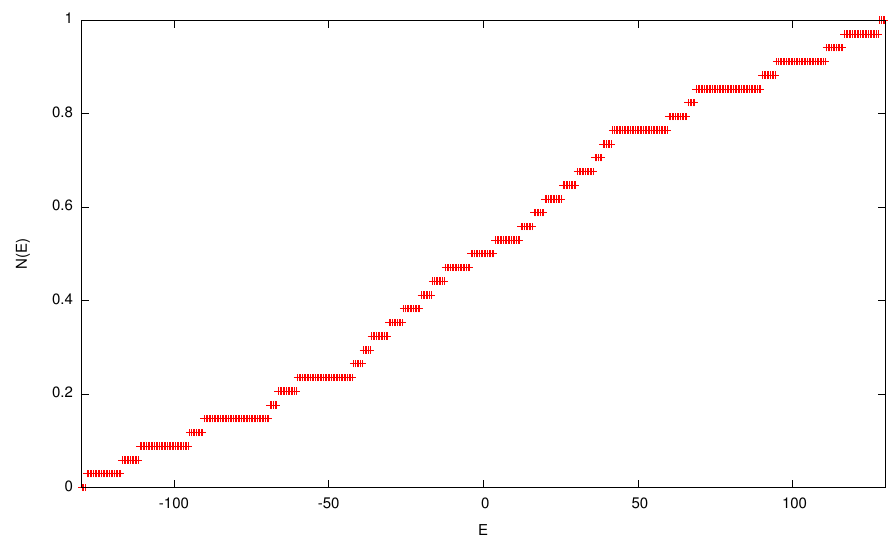
Figure 6 . Integrated Density of States after removing the degeneracies.